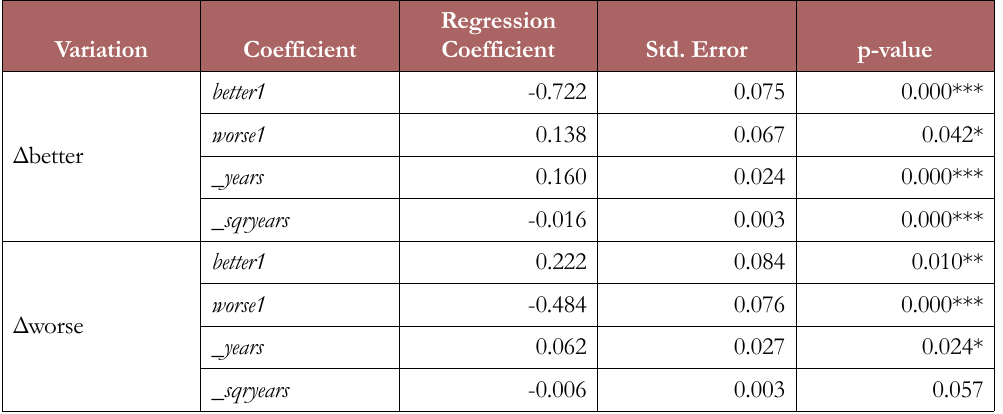
Table 4. Outcomes of the linear regressions that predict the alteration of